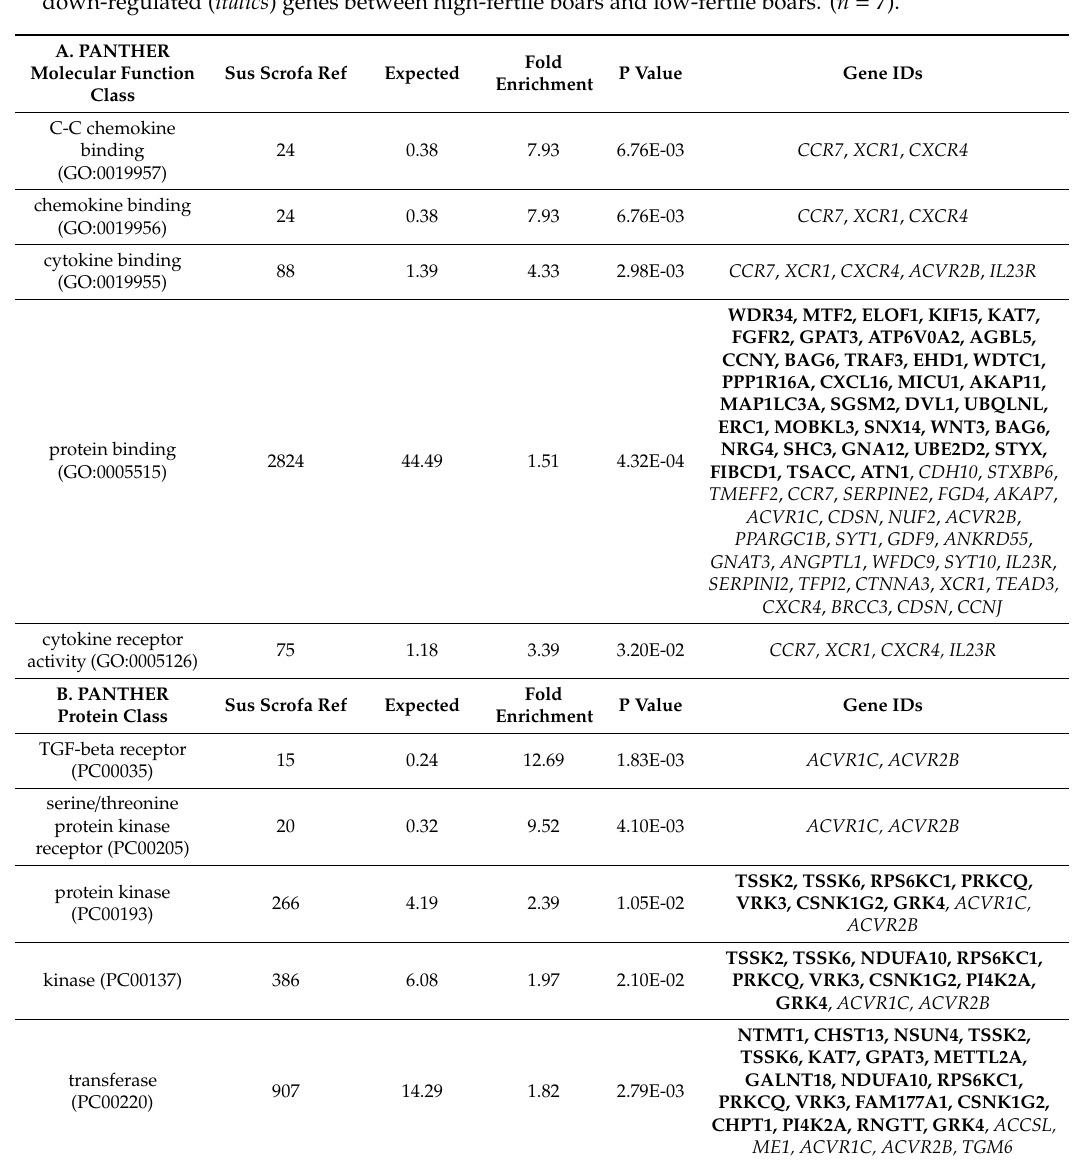
Table 3. Overrepresentation analysis (PANTHER) of the DEGs between high-fertile and low-fertile boars, according to A. PANTHER molecular function class and B. PANTHER protein class. In both overrepresentation analysis, the expected number of genes in the Sus scrofa reference genome is compared with the observed number of genes in the category, resulting in a fold enrichment is indicated in the table ( p < 0.05 as significant level). The column “Genes IDs” depicts the up-regulated ( bold ) and down-regulated ( italics ) genes between high-fertile boars and low-fertile boars. ( n =